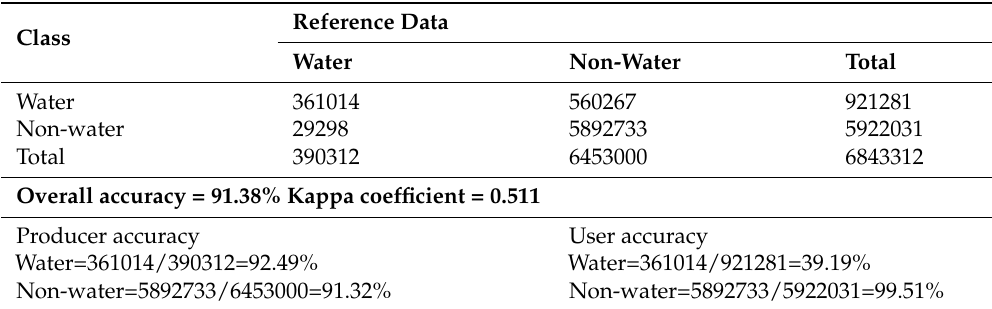
Table 5. Error matrix of the ALG3 classified image (Dataset 1).